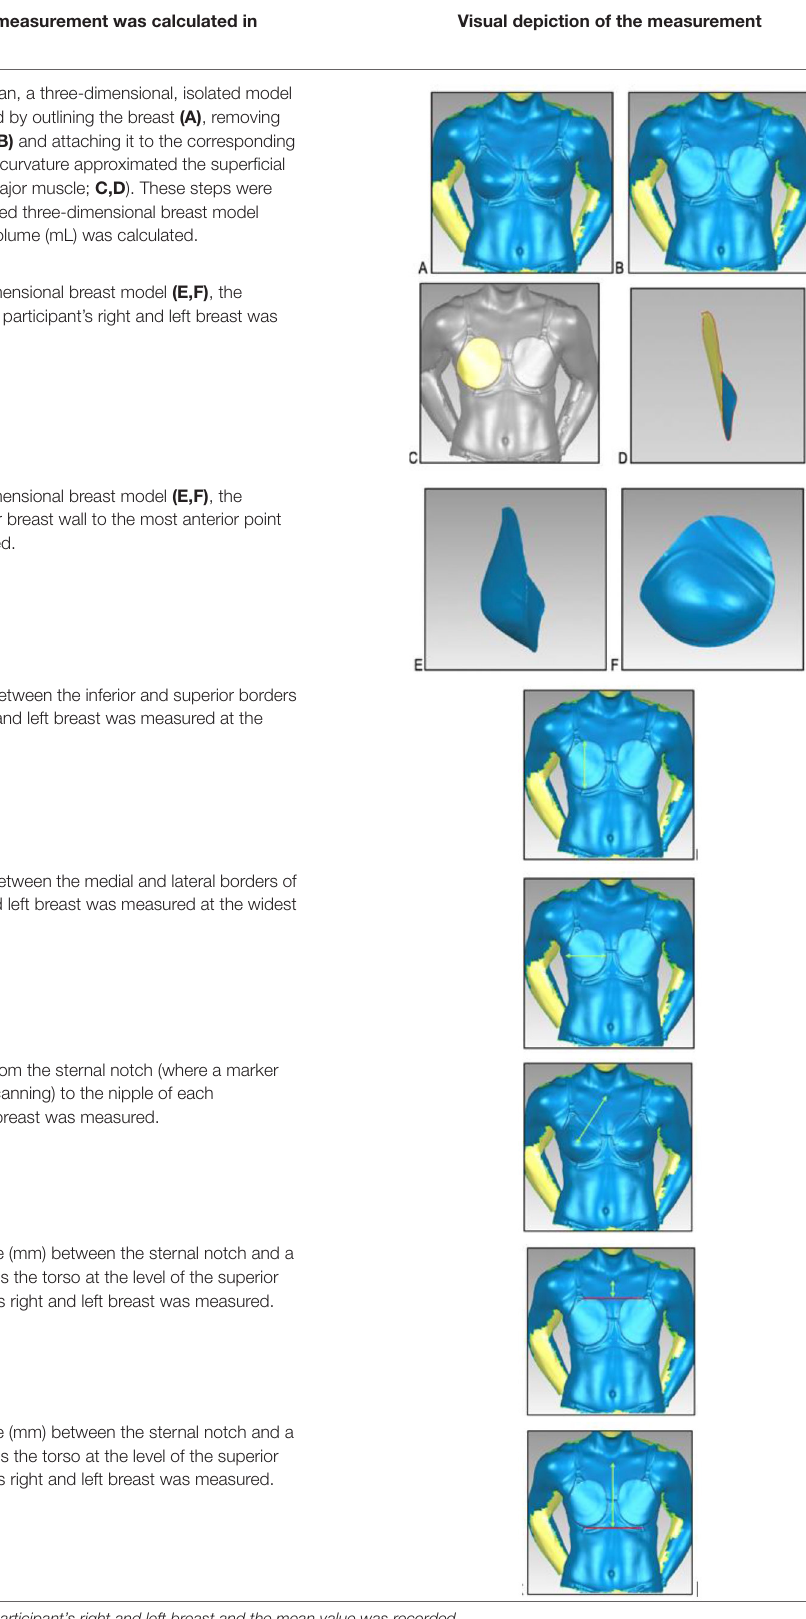
TABLE 3 | A description of how each breast measurement was digitally calculated, as well as a visual depiction of the measurement in Geomagic. Measurement Description of how the measurement was calculated in Geomagic